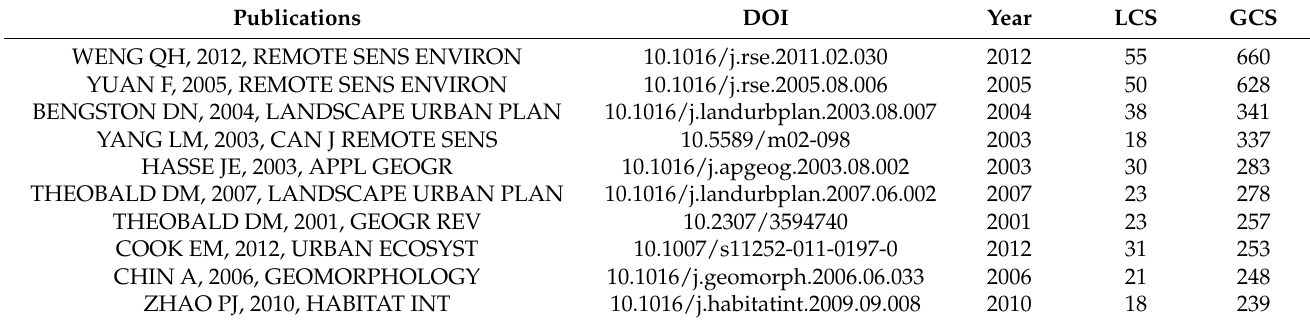
Table 5. Top 10 GCS-ranked publications in the field of urban land management from 1979 to